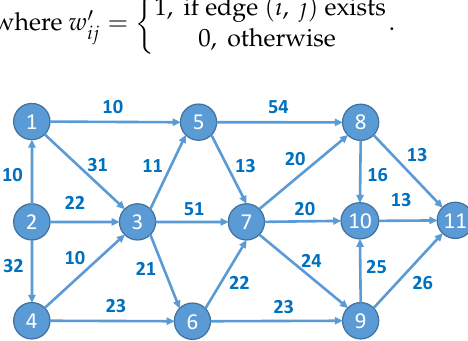
Figure 2. A sample graph representing the fog network.